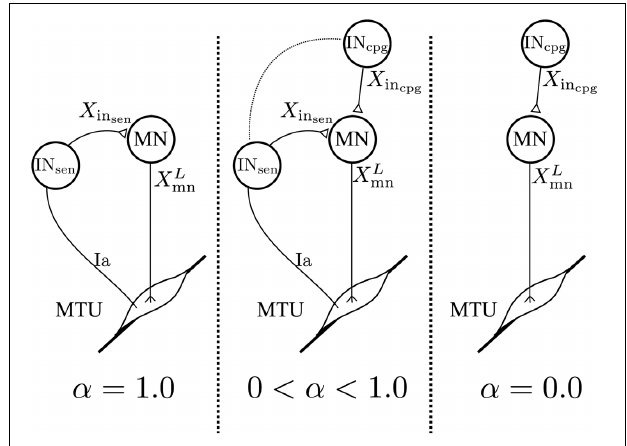
FIGURE 2 | Schematic representation of the spinal network for a specific feedback pathway. The value of α controls the proportion of feedback vs. feedforward. With α = 1 . 0 the feedback pathway is solely feedback-driven. With α = 0 . 0 the feedback pathway becomes a feedforward pathway. All values in-between create a feedback/feedforward